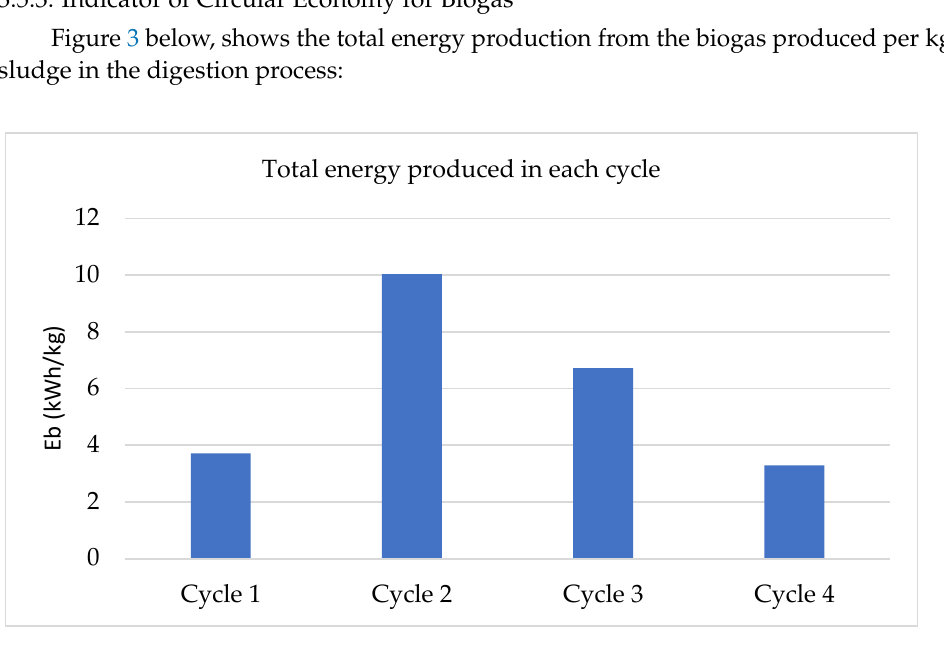
Figure 3. Energy produced by a kg of sludge during digestion.